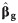
Correlation between SNP-taxa and IBD-taxa effect estimates.The 168 bacterial taxa were tested for association with the variants from each of the four genes considered: (a) ATG16L1 (rs12994997), (b) CARD9 (rs10781499), (c) LRRK2 (rs11564258), and (d) NOD2 (rs2066844, rs2066845, and rs2066847). The histograms on the left panel show the distribution of IBD risk alleles-bacteria association (i.e. of β^g, the regression coefficients) and the enrichment for negative effects (in blue, p-values equal 7.1x10-5, 3.3x10-8, 1.3x10-8, and 5.3x10-3, respectively). Panel (e) shows a similar histogram while merging the per-risk allele change in bacteria level of the four genes (i.e. summing for each bacteria the β^g of the four genes). Panel (f) shows the distribution of bacteria-IBD association derived in a IBD cases-controls dataset (β^B) for each bin from panel (e). Together, panels (e) and (f) show the strong concordance of the gene-bacteria and bacteria-IBD effects, in agreement with a mediation effect of the risk allele on IBD through the microbiome. In particular, bacteria displaying lower level in carrier of IBD risk alleles are more likely to be negatively associated with the risk of IBD.